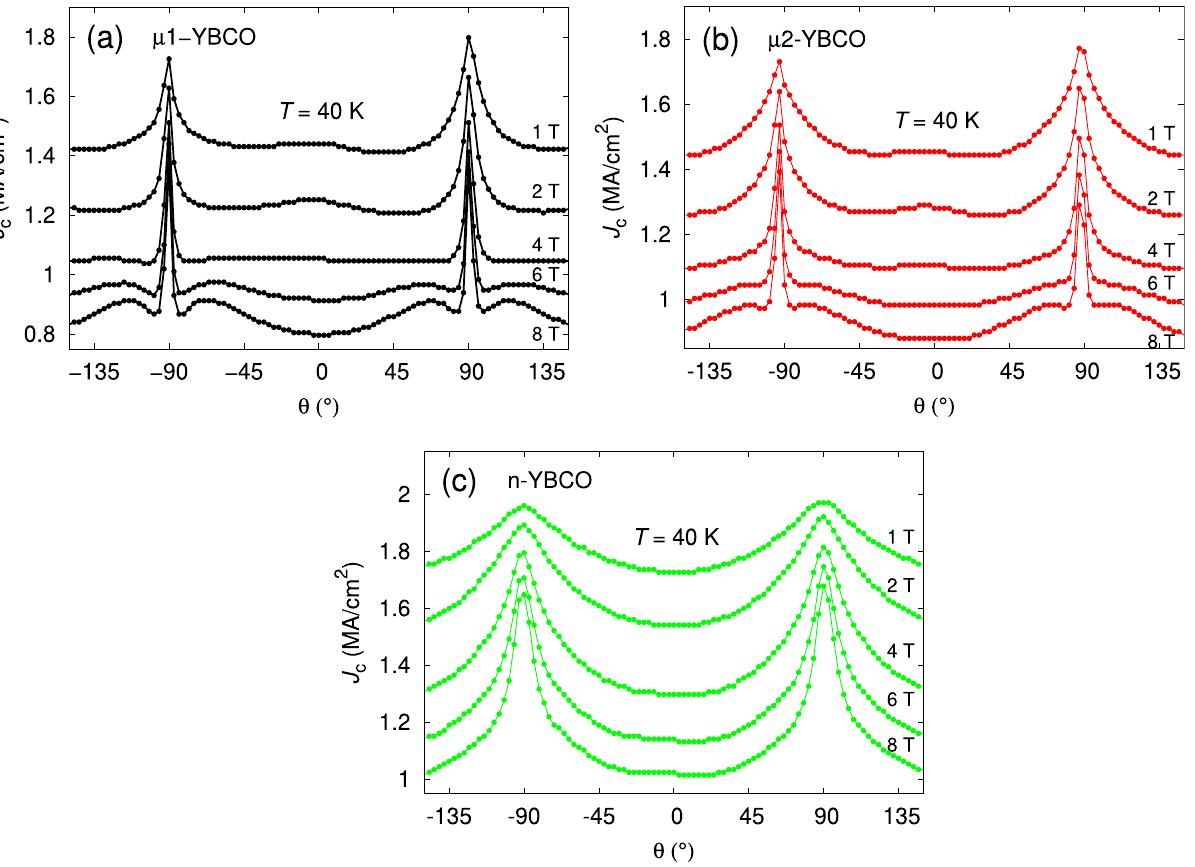
Figure 4. The angular dependencies of J c measured at 40 K and in wide magnetic field range up to 8 T for undoped µ 1-, µ 2- and n-YBCO films. The angles θ = − 90 ◦ and 90 ◦ correspond to the ab -plane and θ = 0 ◦ the YBCO c